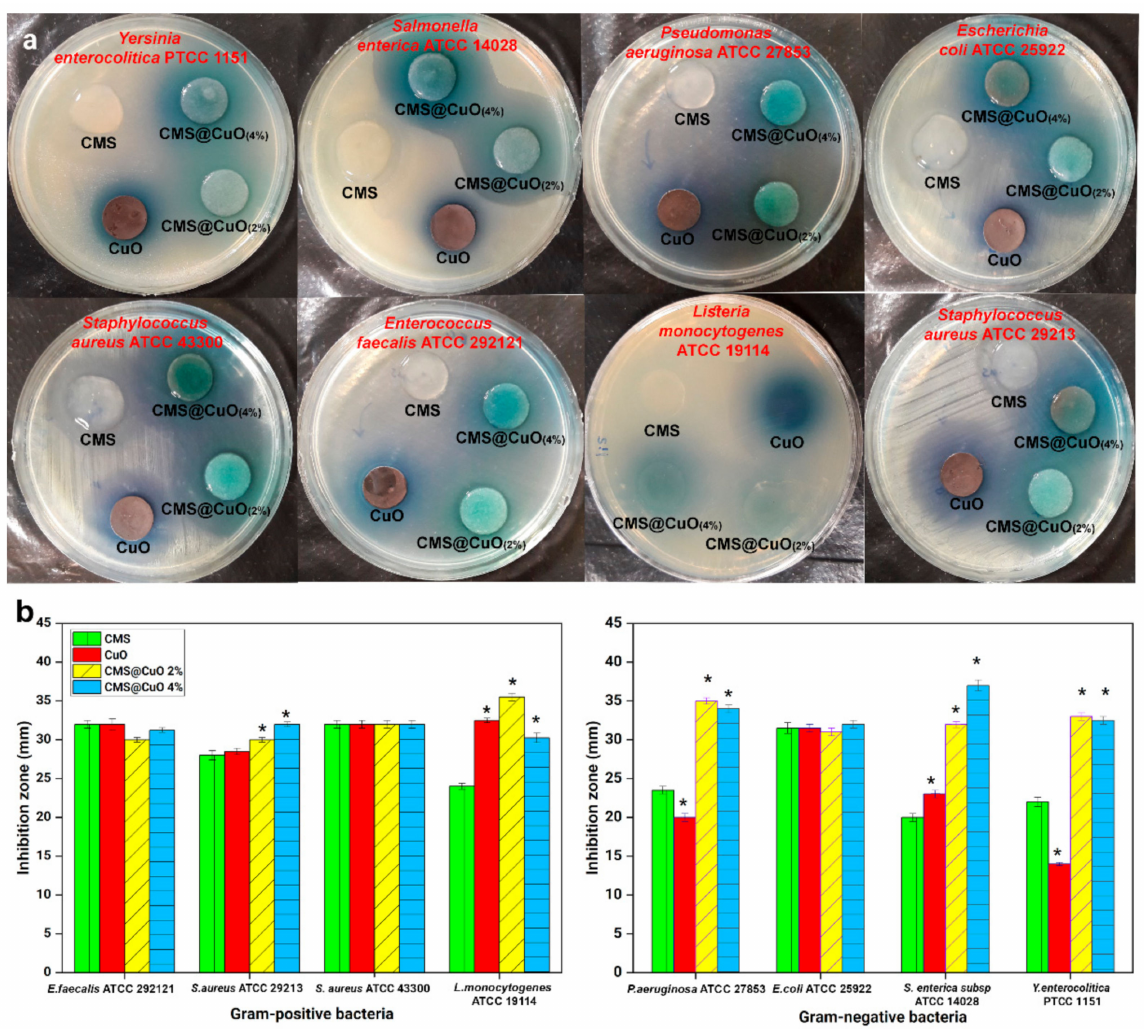
Figure 5. Antibacterial activity of CMS, CuO nanoparticles, the CMS@2%CuO nanocomposite hydrogel, and the CMS@4%CuO nanocomposite hydrogel against different Gram-positive and Gram-negative bacteria. ( a ) cell cultures ( b ) charts. For each chart, columns marked with asterisks (*) denote significant difference compared with pure CMS ( p <